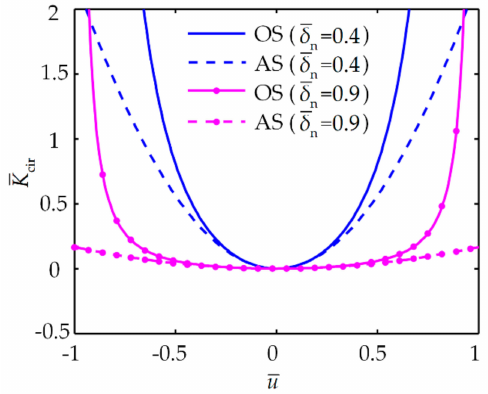
Figure 9. Comparisons between original and approximate sti ff ness curves of cam with semicircular